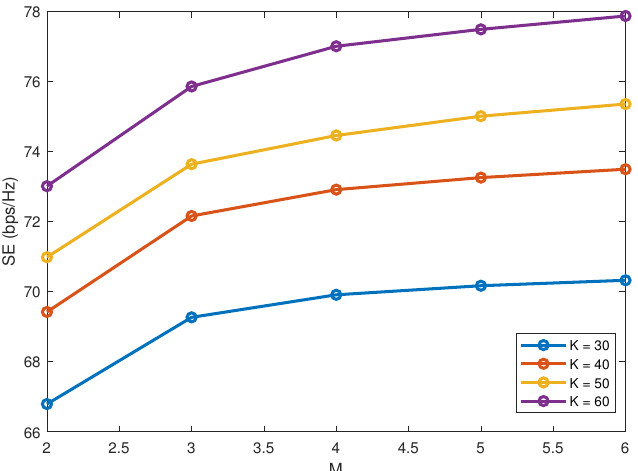
Figure 1. Spectrum efficiency (SE) versus M .